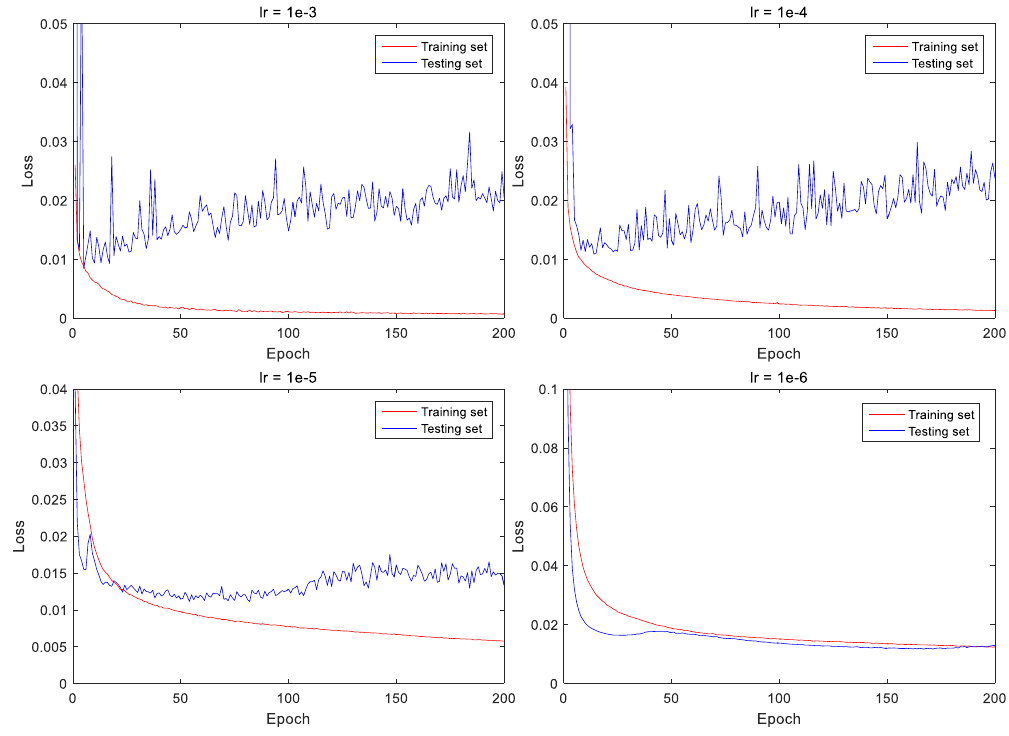
Figure 9. Loss function curves of training and validation datasets under four different learning rates.